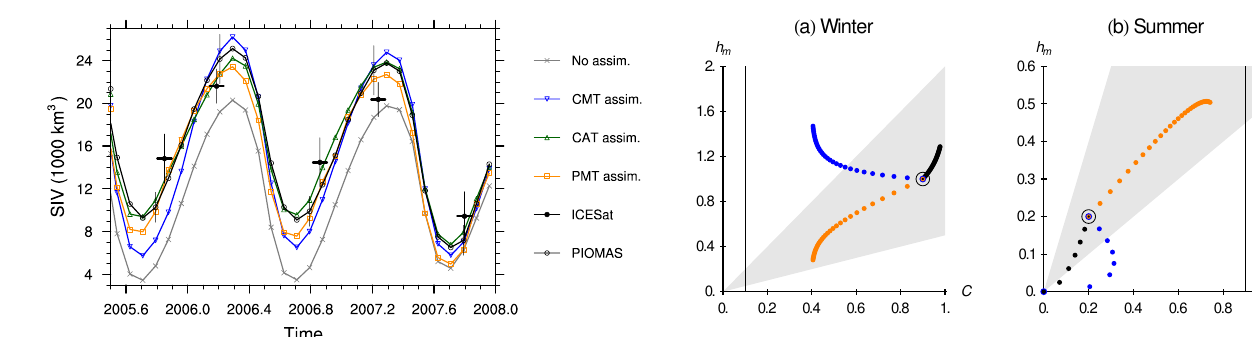
Fig. 6. Trajectories of the sea-ice state in the ice energy balance model with and without assimilation for one month of (a) constant winter forcing and (b) constant summer forcing. Positions for each day are marked by black points (trajectory without assimilation), blue points (trajectory with CMT assimilation), and orange points (trajectory with PMT assimilation). All trajectories start from the same initial conditions marked by the black circle. The target ice concentration is marked by a thin vertical line. The nudging param- eters are as in the AOGCM experiments. Mean ice thickness for a given concentration in the AOGCM is typically within the grey shaded